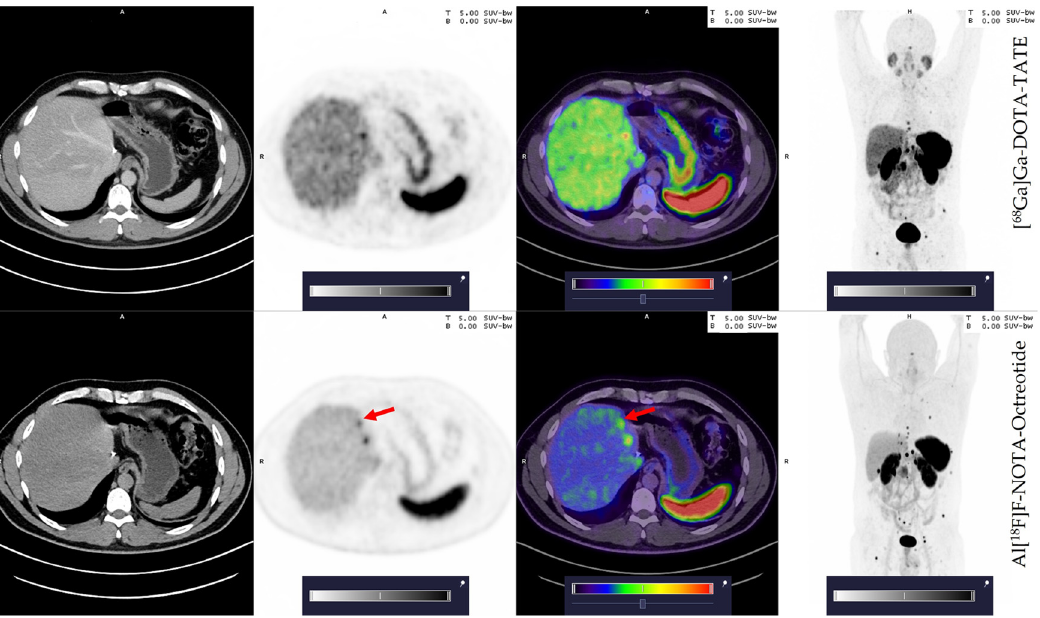
Figure 3. Patient 10; 42 years old, male with an additional small liver lesion (red arrow) detected by Al[ 18 F]F-NOTA-Octreotide (lower row) and not seen with [ 68 Ga]Ga-DOTA-TATE (upper row). Colour scale bar representing SUV values ranging from 0.0–5.0. Table 3. Neoplastic lesions detected with [ 68 Ga]Ga-DOTA-TATE and Al[ 18 F]F-NOTA-Octreotide.